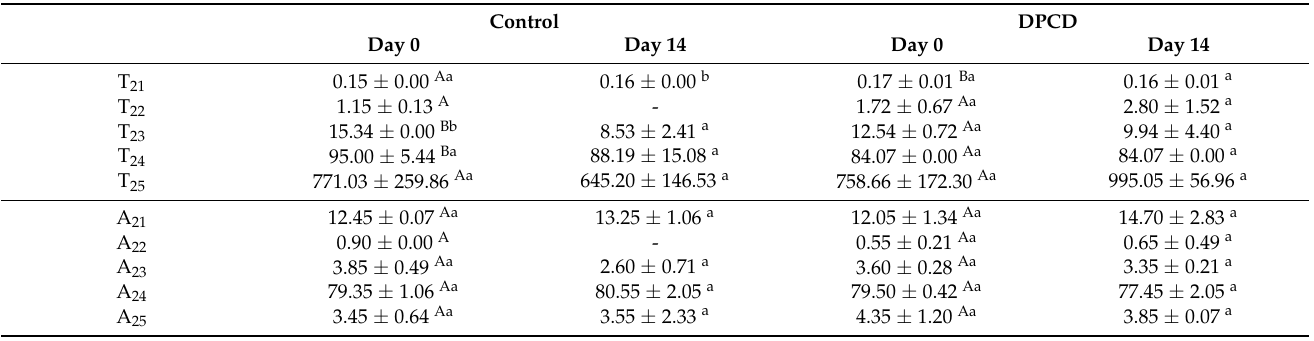
Table 5. Relaxation time (T 2i ) and relative content ( A 2 i ) of control and dense-phase carbon dioxide (DPCD)-processed cheese stored at 4 ◦